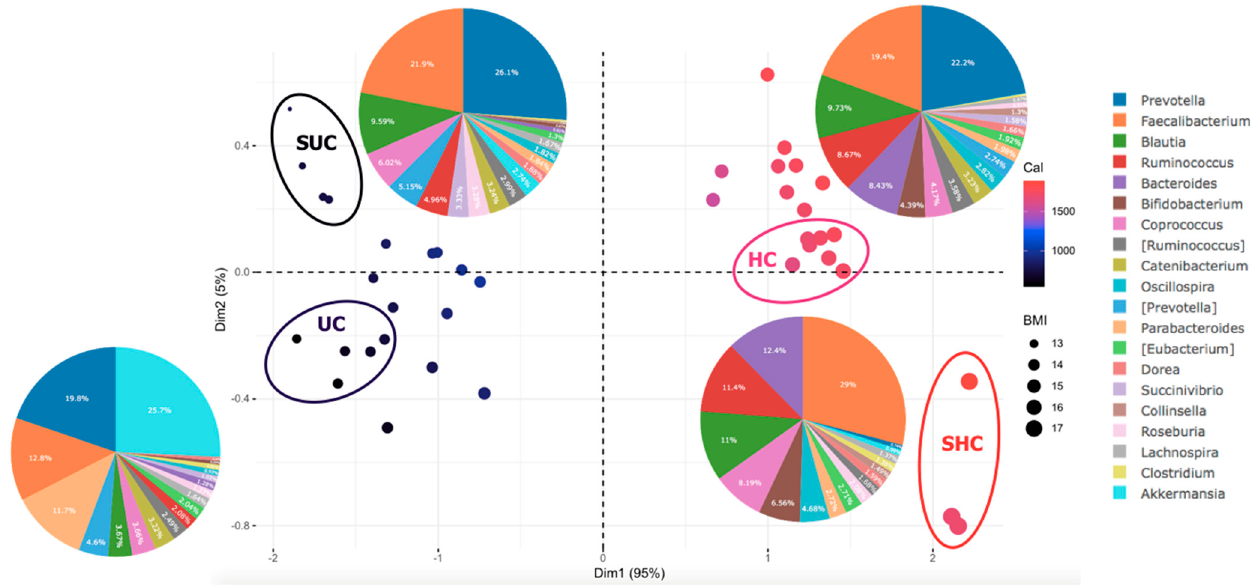
Figure 7. Principal component analysis (PCA) plot of 40 children related to calorie intake and BMI. The calorie intake (Cal) and BMI of each sample are represented by dots and color, respectively. The group sample was selected based on the four regions and circled with letters denoting the groups, namely SUB (severely undernourished children), UC (undernourished children), HC (healthy children), and SHC (super healthy children). The genus composition was averaged and graphed in the pie charts.